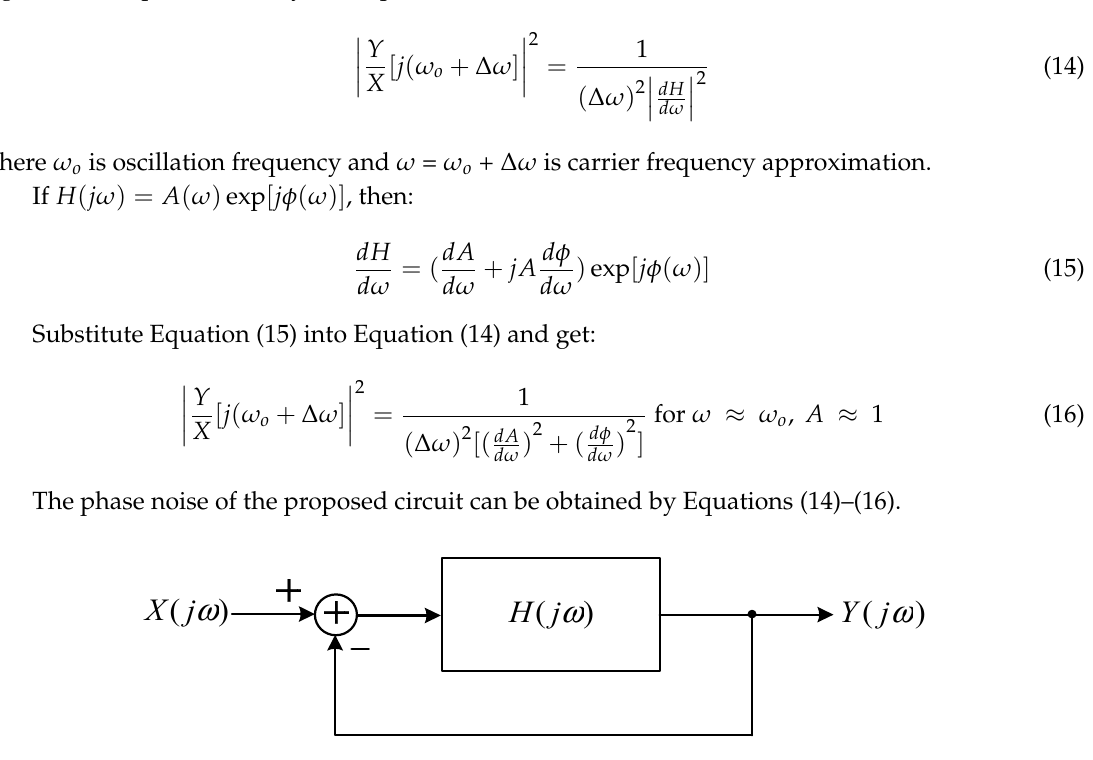
Figure 4. Linear oscillatory system in Reference [35].